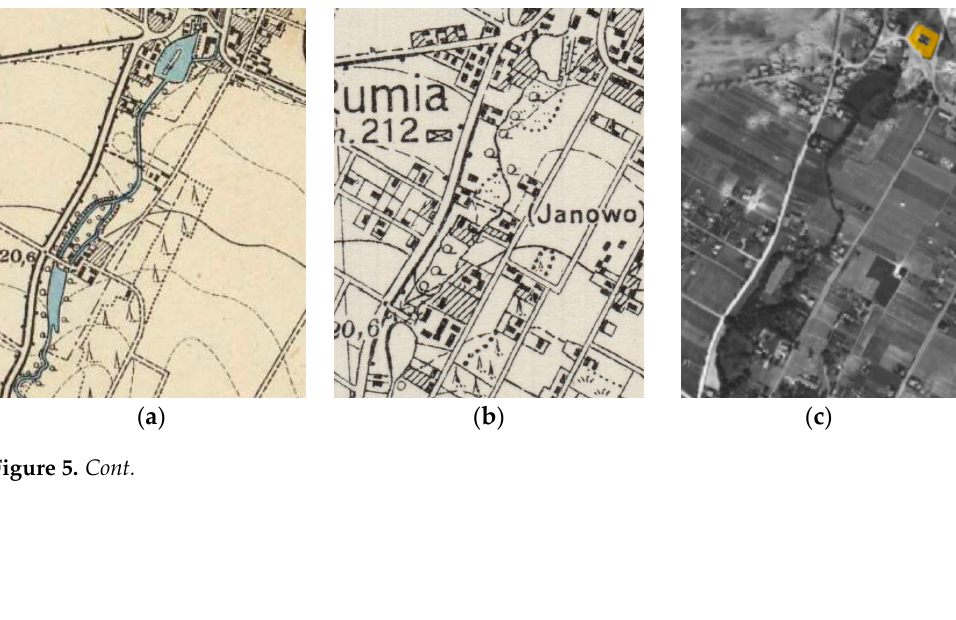
Figure 4. The manor house “Dwór pod lipami” from the second half of the 18th century; ( a ) before